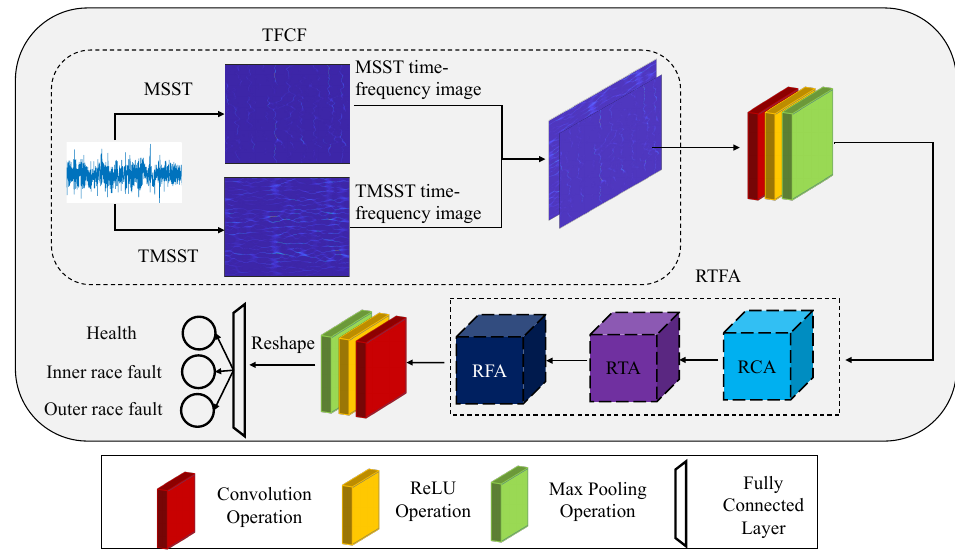
Figure 1. Overall model